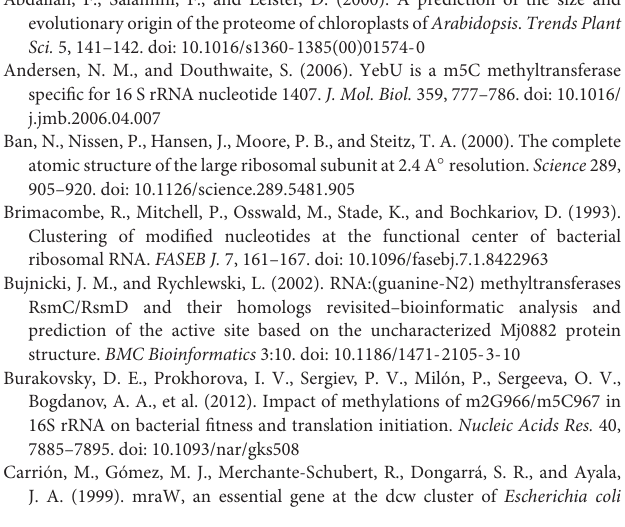
Supplementary Figure 5 | Alignment of 16S rRNAs from different organisms. Sequence identifiers for RsmD homologs are as follows: Oryza sativa (MK348618.1), Brachypodium distachyon (LR537486.1), Hordeum vulgare , (MN171392.1), Sorghum bicolor (MK348612.1), Zea mays